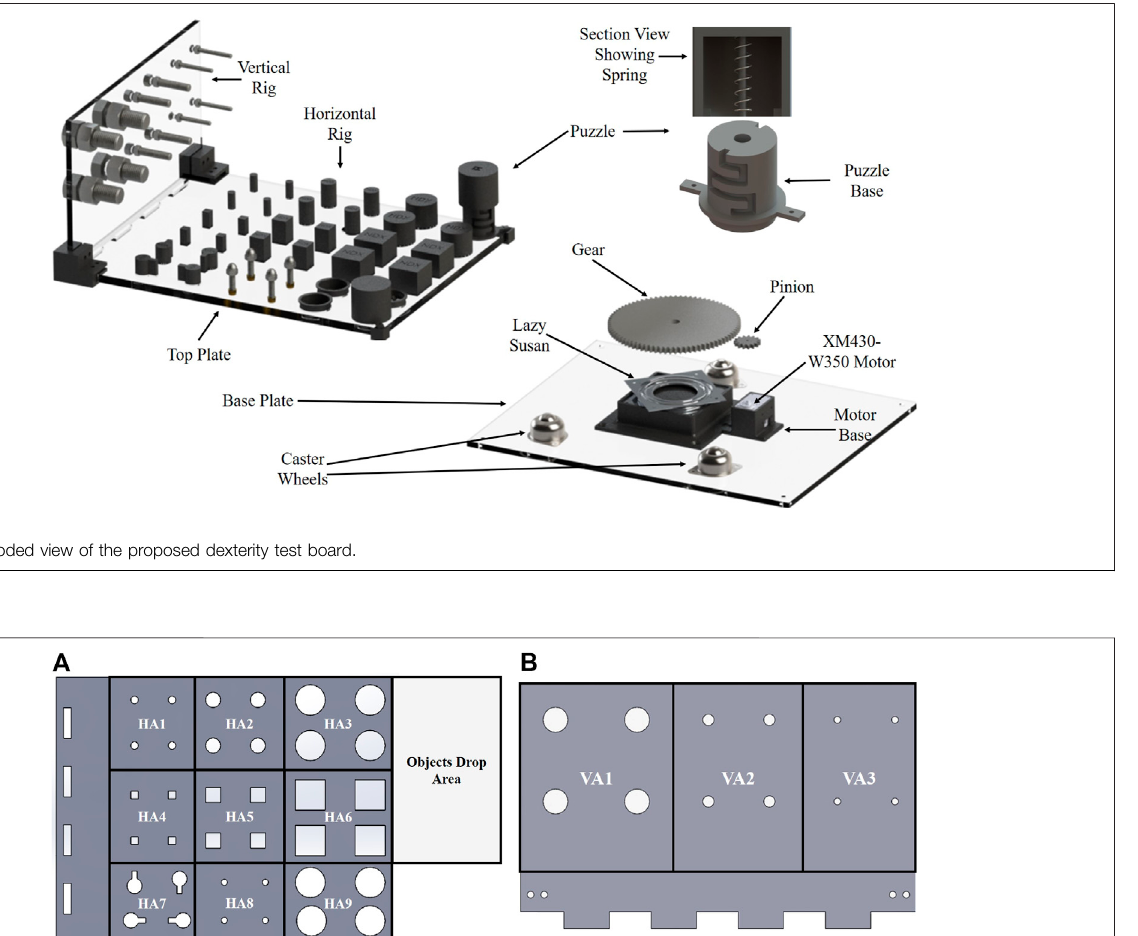
Frontiers in Robotics and AI |